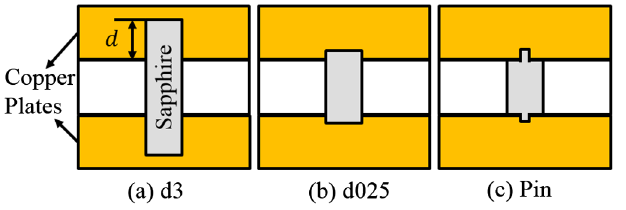
FIG. 6. Schematic comparison of the three HPBG structures.